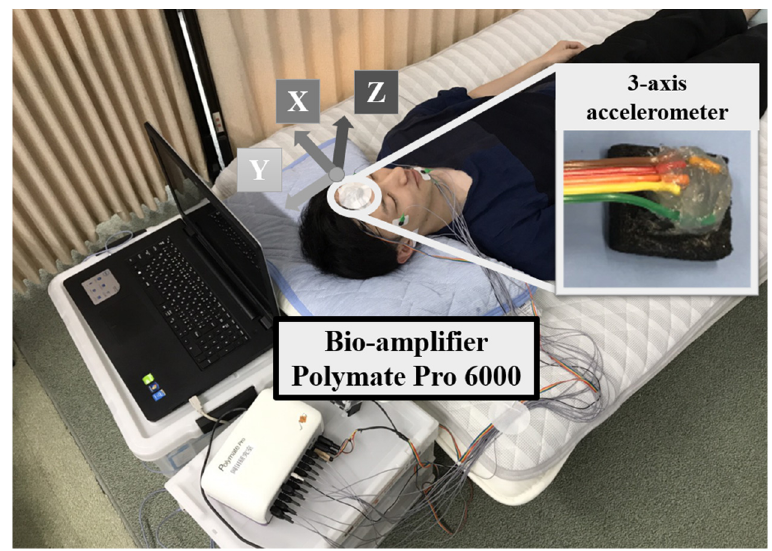
Figure 1. Example of the measurement environment.